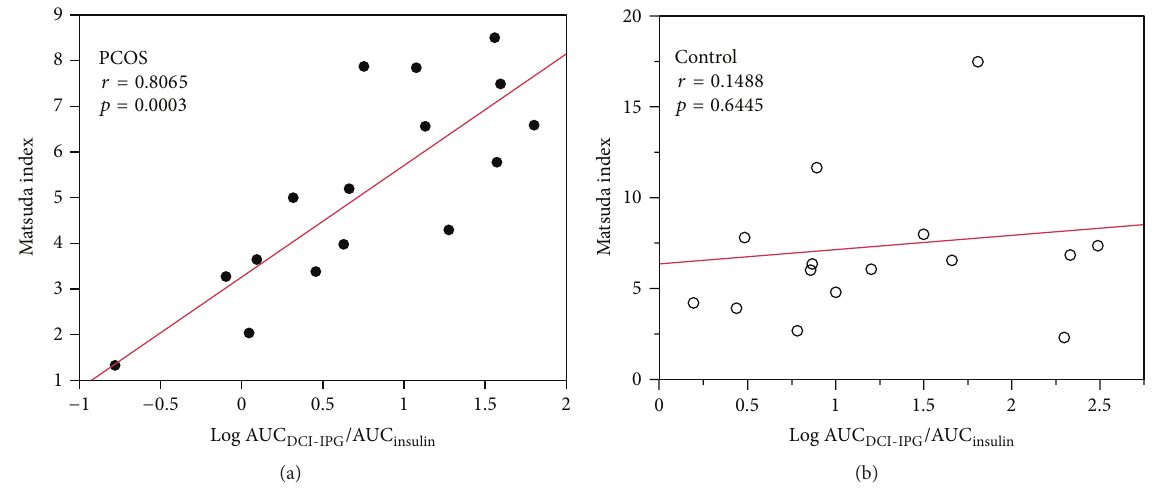
Figure 1: Relationship between baseline Matsuda index and release of the bioactive DCI-IPG messenger per unit of insulin released during OGTT in PCOS ( e , a) and normal ( l , b) women. DCI-IPG, D-chiro-inositol-inositolphosphoglycan mediator.